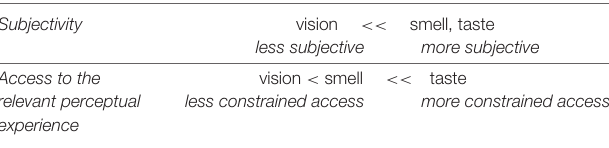
TABLE 1 | Vision, taste, and smell grouped by level of subjectivity and ease of perceptual